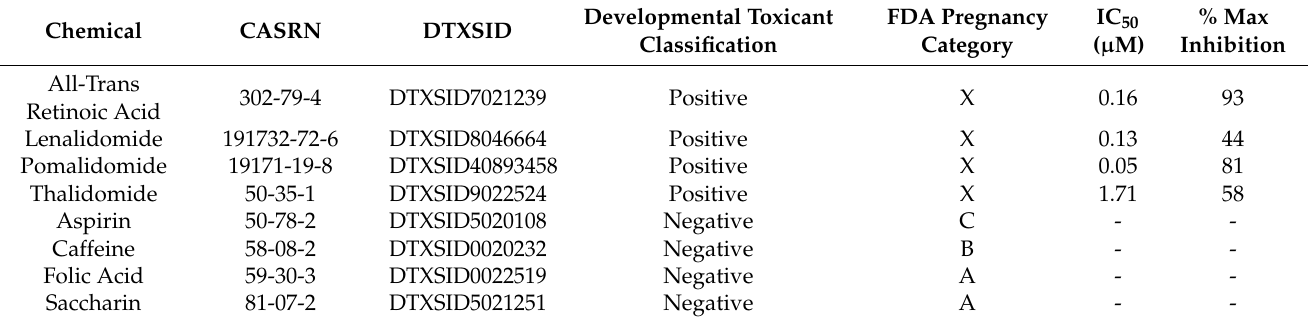
Table 1. Reference chemicals. Chemical name, CAS registry number (CASRN), DSSTox